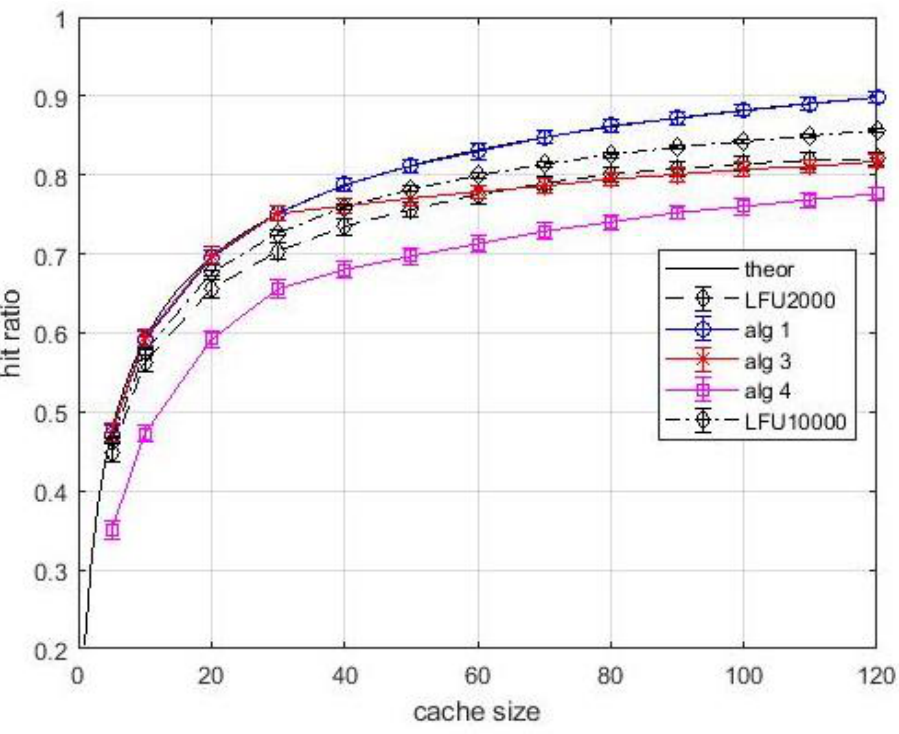
Figure 5. Hit ratio, case 1, N =